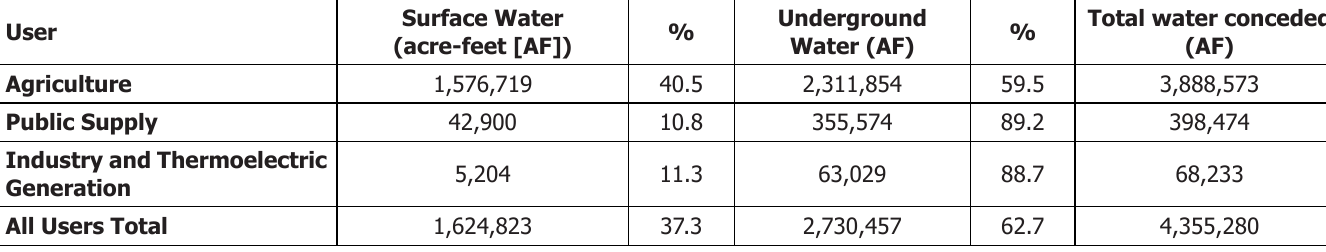
Table 2. Water concessions by user in Chihuahua, 2020.